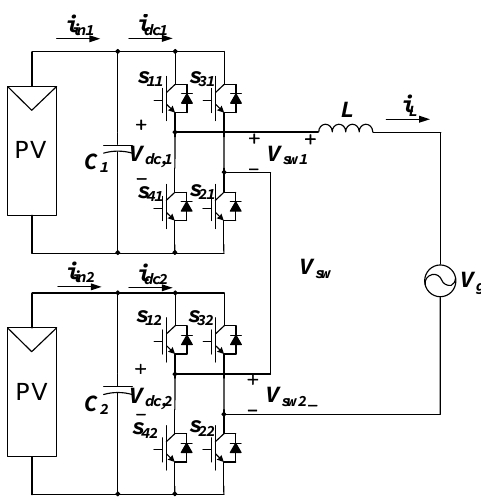
Figure 1. Single-phase photovoltaic cascaded H-bridge multilevel inverter.